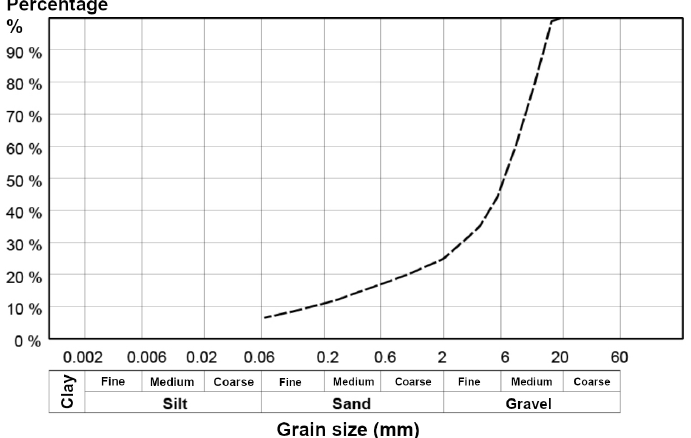
Figure 1. Grain size distribution for soil used in this